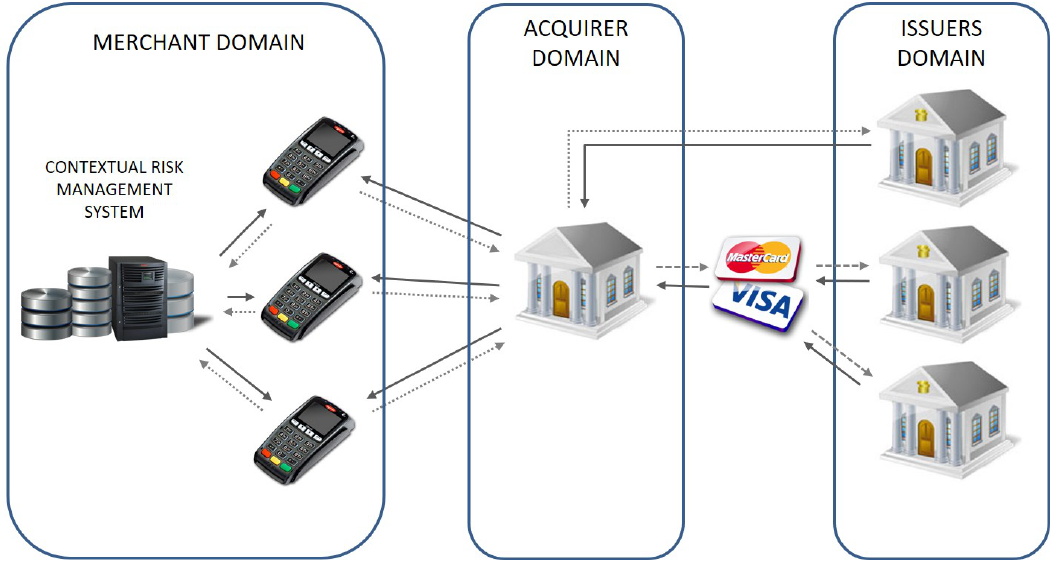
Figure 2. High-level Contextual Risk Management System architecture, based on